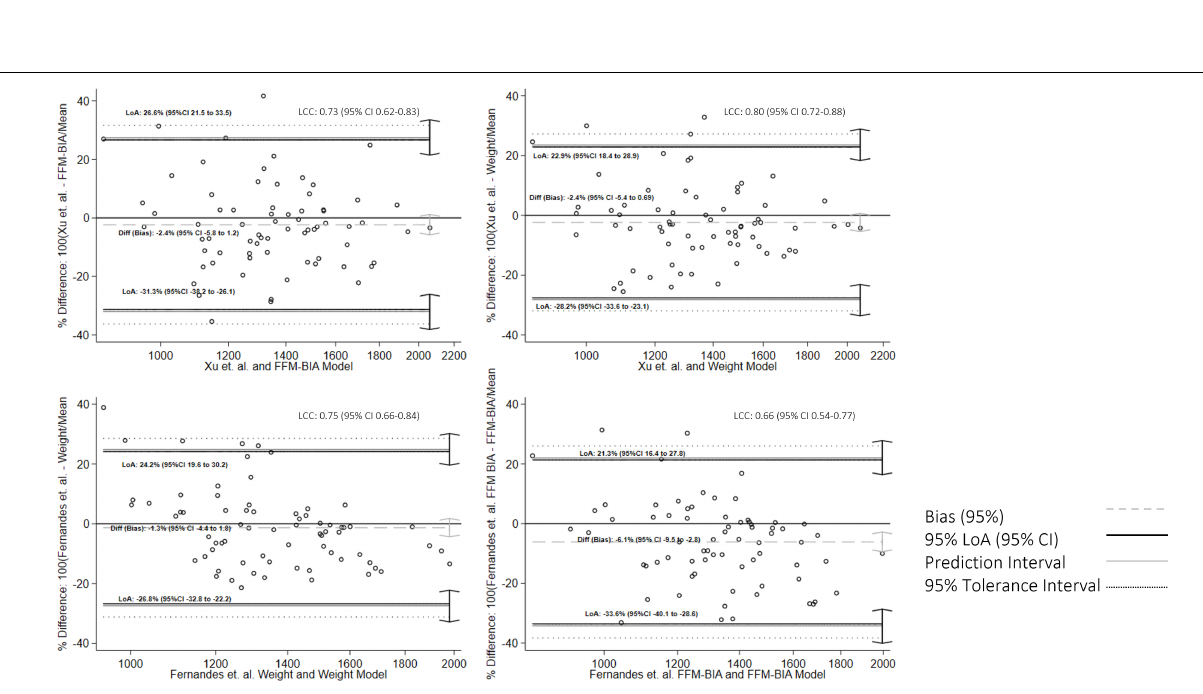
Frontiers in Nutrition |